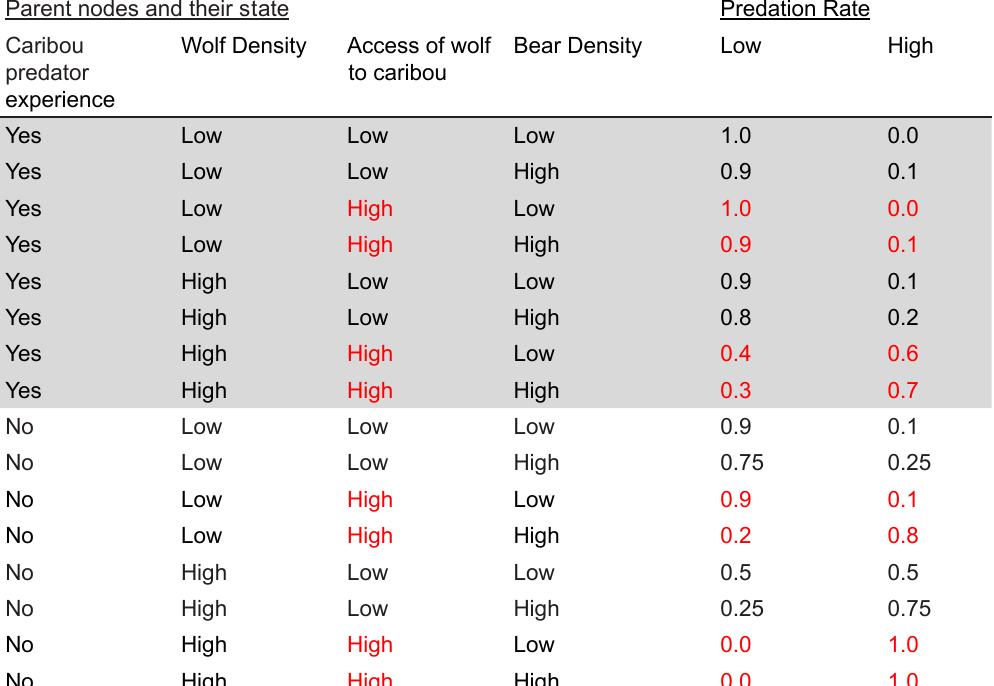
Table A5. Conditional probability table for node predation rate. Parent nodes and their